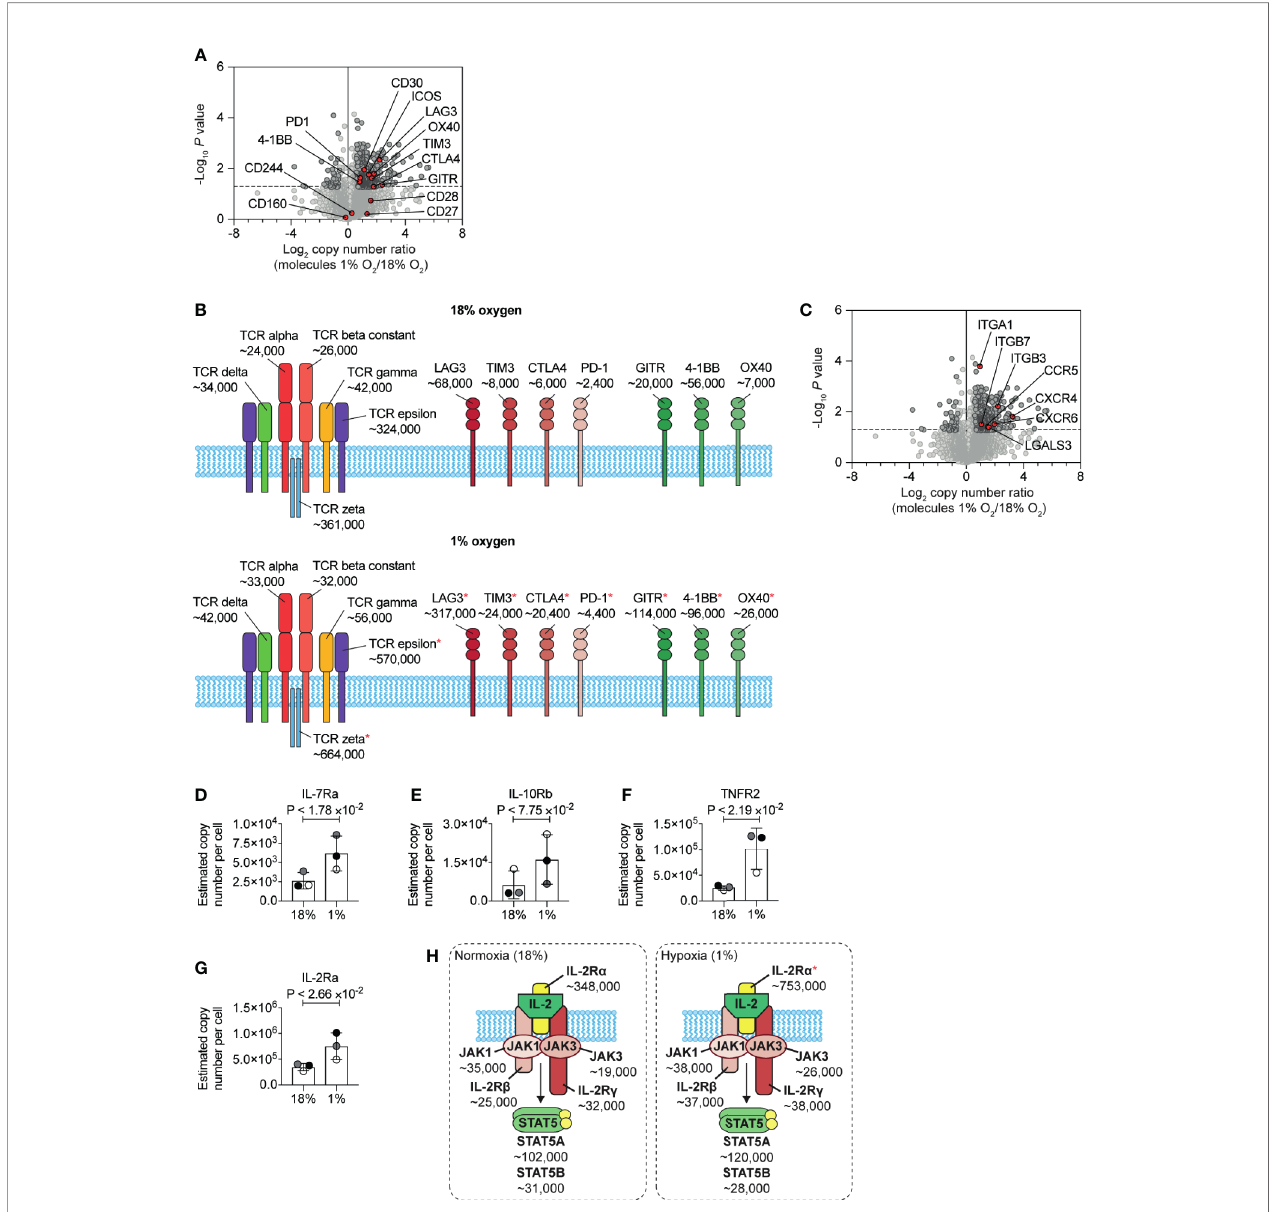
FIGURE 6 | Changes to plasma membrane receptors induced by hypoxia. (A) Volcano plot showing the protein copy number ratio in CTLs subjected to 24 hours of hypoxia (1% O 2 ) compared to CTLs maintained in normoxia (18% O 2 ) with co-stimulatory and inhibitory checkpoint molecules annotated and highlighted in red. (B) Schematic representation of the T cell receptor (TCR) and selected co-stimulatory and inhibitory checkpoint molecules. Average copy numbers for three biological replicates of CTLs maintained in normoxia or subjected to 24 hours of hypoxia are annotated alongside, with * indicating the proteins that increase signi fi cantly in abundance in hypoxia. (C) Volcano plot showing the protein copy number ratio in CTLs subjected to 24 hours of hypoxia (1% O 2 ) compared to CTLs maintained in normoxia (18% O 2 ) with selected adhesion molecules and chemokine receptors highlighted in red. (D – G) Copy numbers estimated from the proteomic data for the indicated proteins. (H) Schematic representation of the IL-2 receptor and JAK-STAT5 signalling pathway. Average copy numbers for three biological replicates of CTLs maintained in normoxia or subjected to 24 hours of hypoxia are annotated alongside. Data in (A, C – G) show three biological replicates. Data in (B, H) show average values from three biological replicates. In bar charts, data points from each biological replicate are shown, and are colour matched, the bar shows the mean and the error bars show standard deviation. P values were calculated using a two-tailed paired